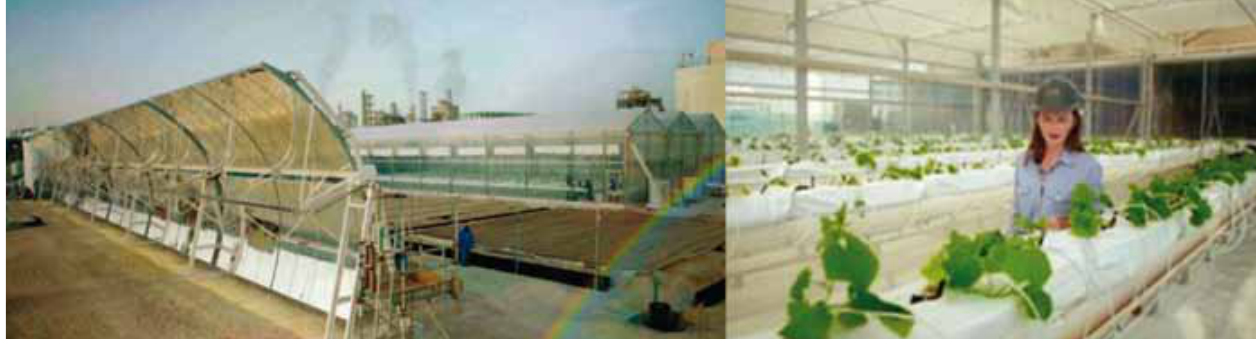
Figure 6 : Cucumber forcing in the desert in the Sahara Desert Project source :